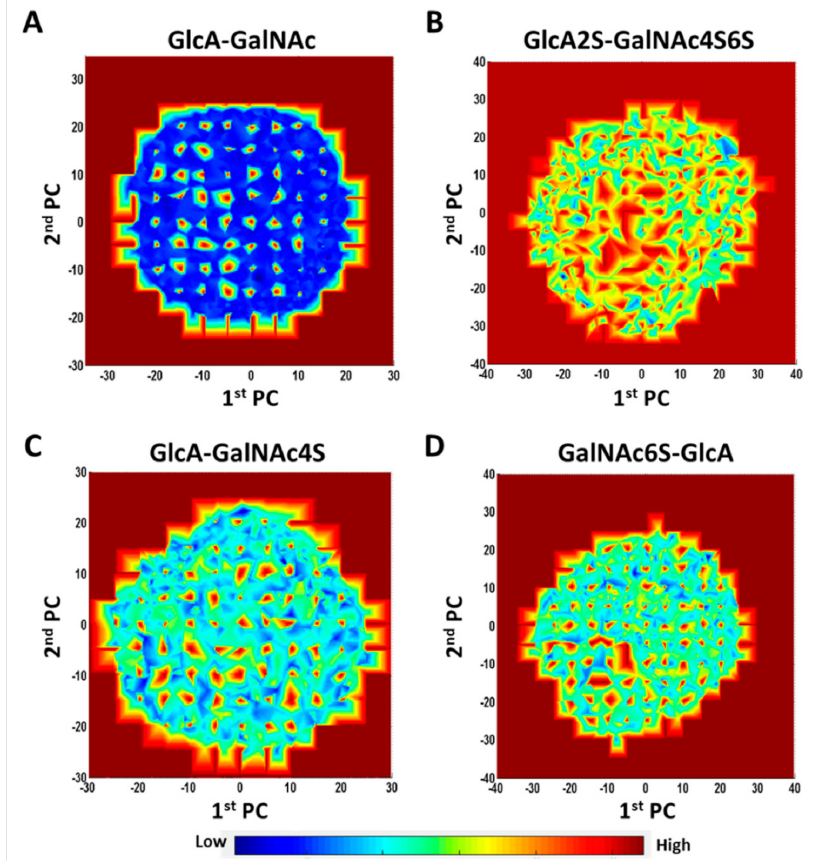
Figure 6. Inherent potential energy landscape of CS disaccharides. Representative landscapes are shown for GlcA-GalNAc ( A ), GlcA2S-GalNAc4S6S ( B ), GlcA-GalNAc4S ( C ) and GalNAc6S-GlcA ( D ). The 2D-contour plots were prepared by projecting the respective potential energy values of the Z axis to the X and Y axes, where the X and Y-axes are the first two principal components (PCs) derived from principal component analysis (PCA) of the MD trajectory representing the conformational